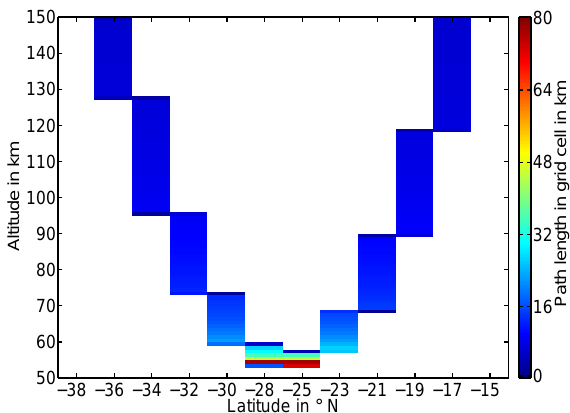
Figure 5. Path lengths in different grid cells for a typical line of sight (LOS) of a limb measurement. The biggest part of the path lies in the tangent point altitude region, but higher altitudes are also passed (taken from Langowski et al.